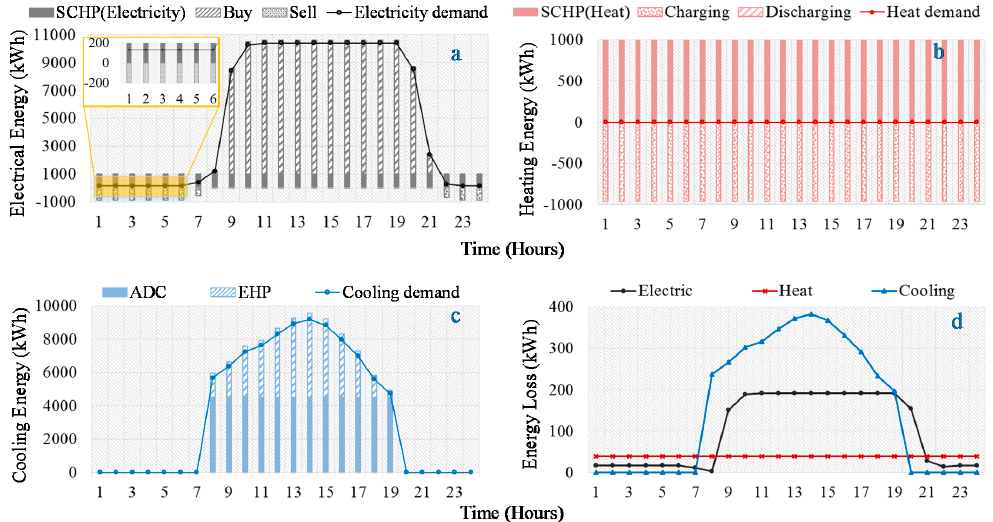
Figure 7. Energy balancing of BMG2 in summer season: ( a ) electrical energy; ( b ) heating energy; ( c ) cooling energy; and ( d ) energy loss.